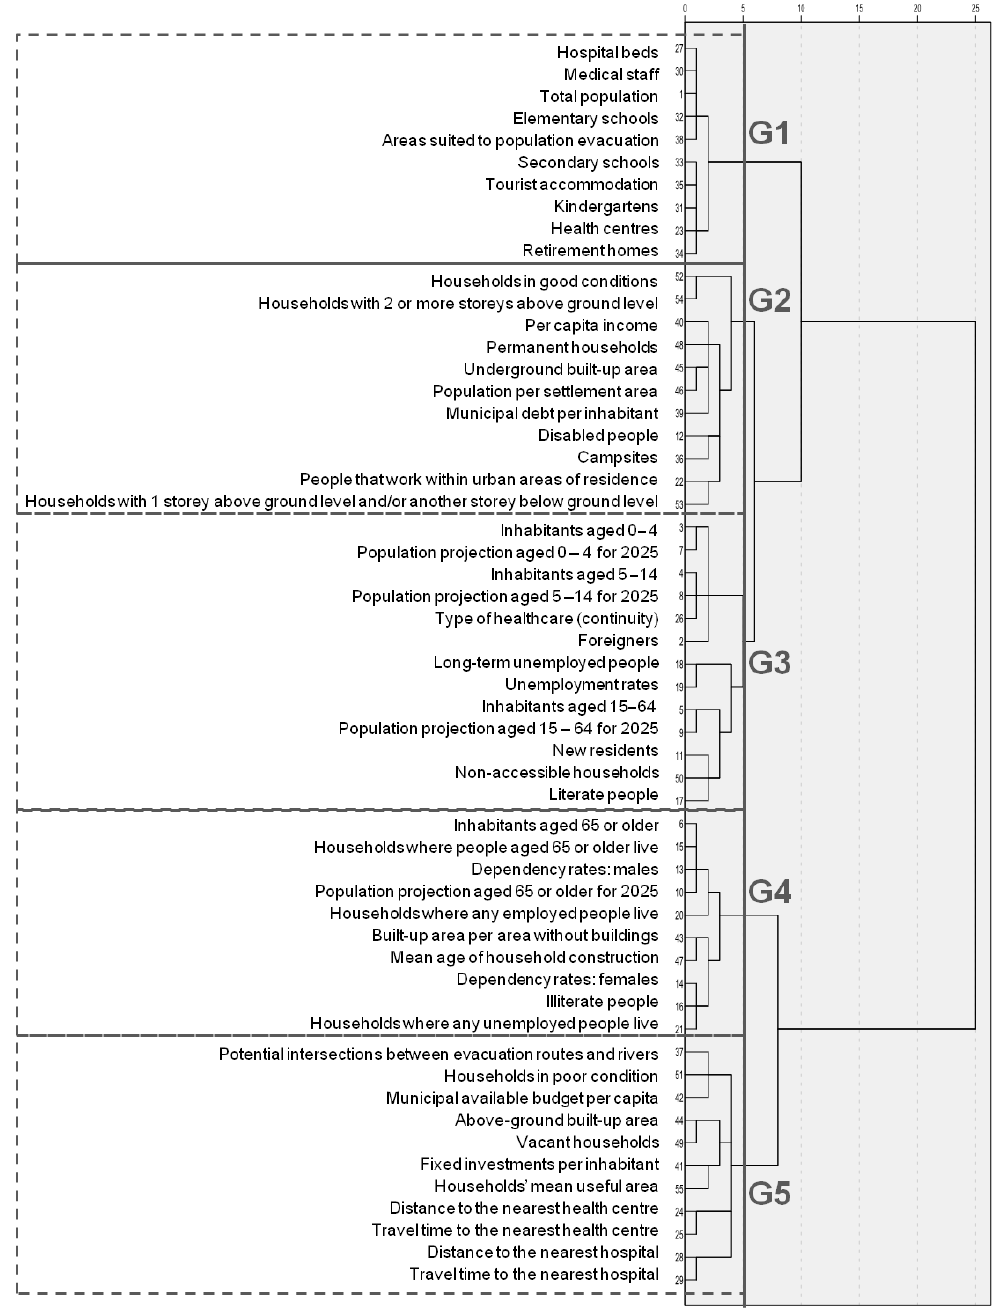
Figure 3. Dendrogram resulting from the HSA. Each rectangle corresponds to an identified group, with a total of five groups (G1, G2, G3, G4 and